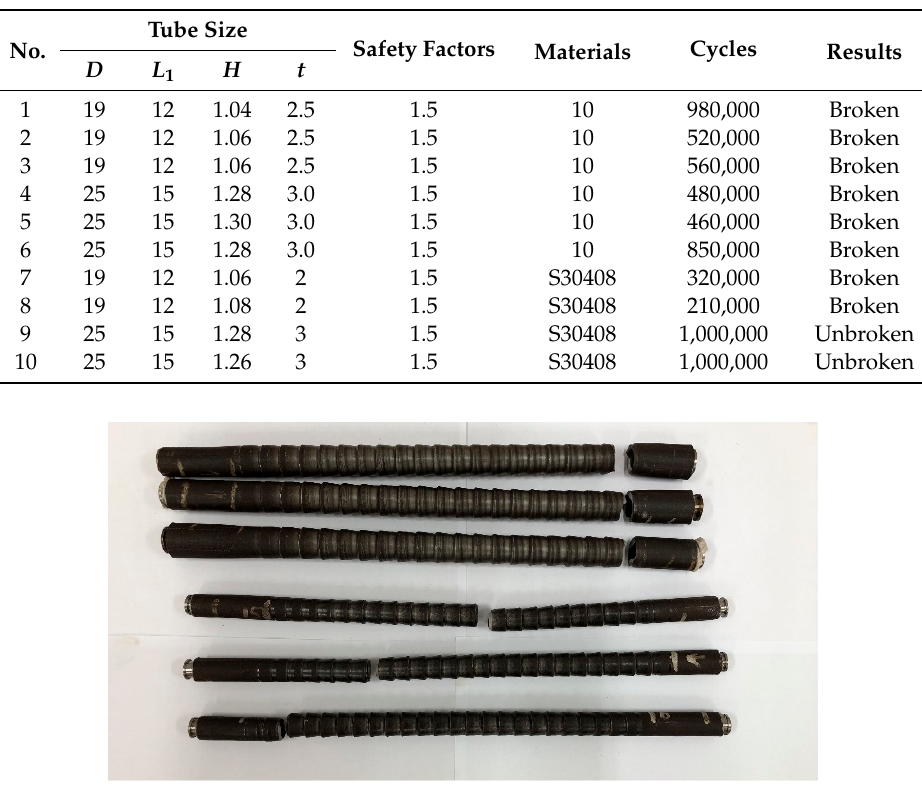
Figure 3. Some fractured CD tubes.